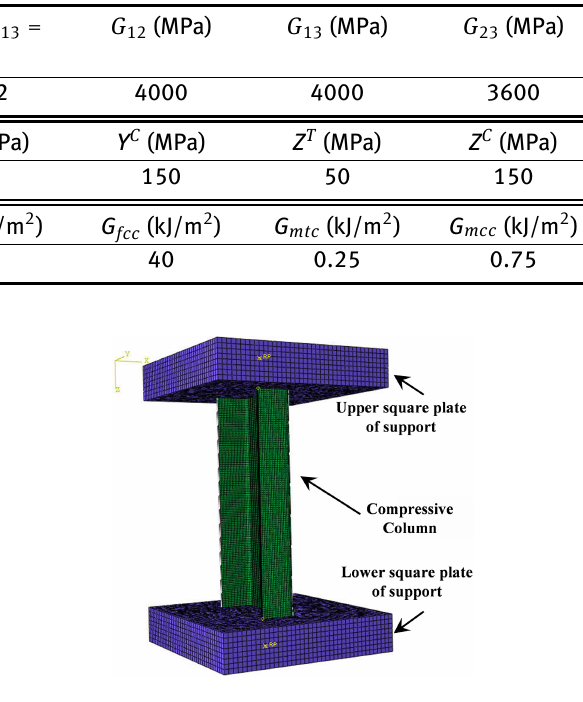
Figure 9: Finite element model of a compressive laminated column with a single-channel cross